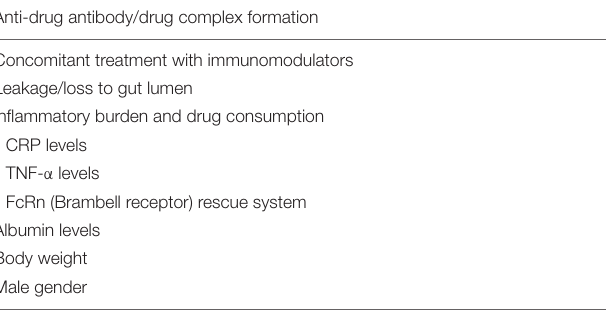
TABLE 3 | Potential factors affecting biologic drug levels/drug clearance (27, 173, 174). Anti-drug antibody/drug complex formation Concomitant treatment with